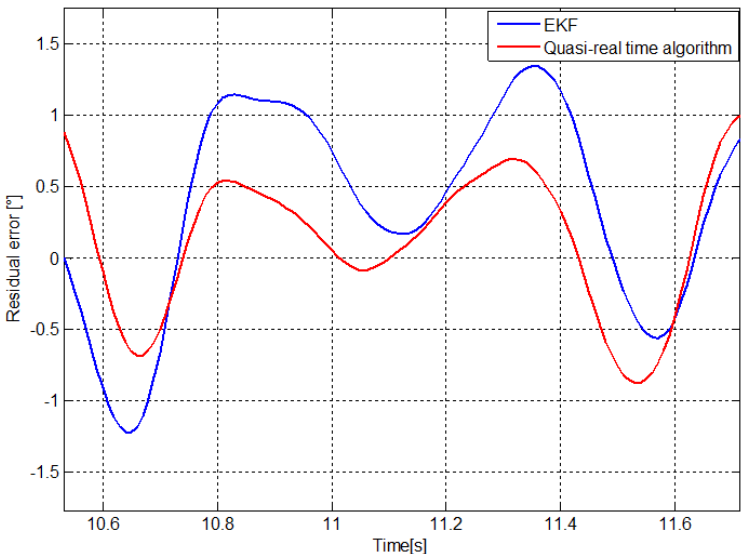
Figure 7. Residual error of the knee flexion-extension angle estimated by the quasi-real time algorithm and the EKF fusing accelerometers and gyroscope outputs. The angle estimated by stereo-photogrammetry was used as